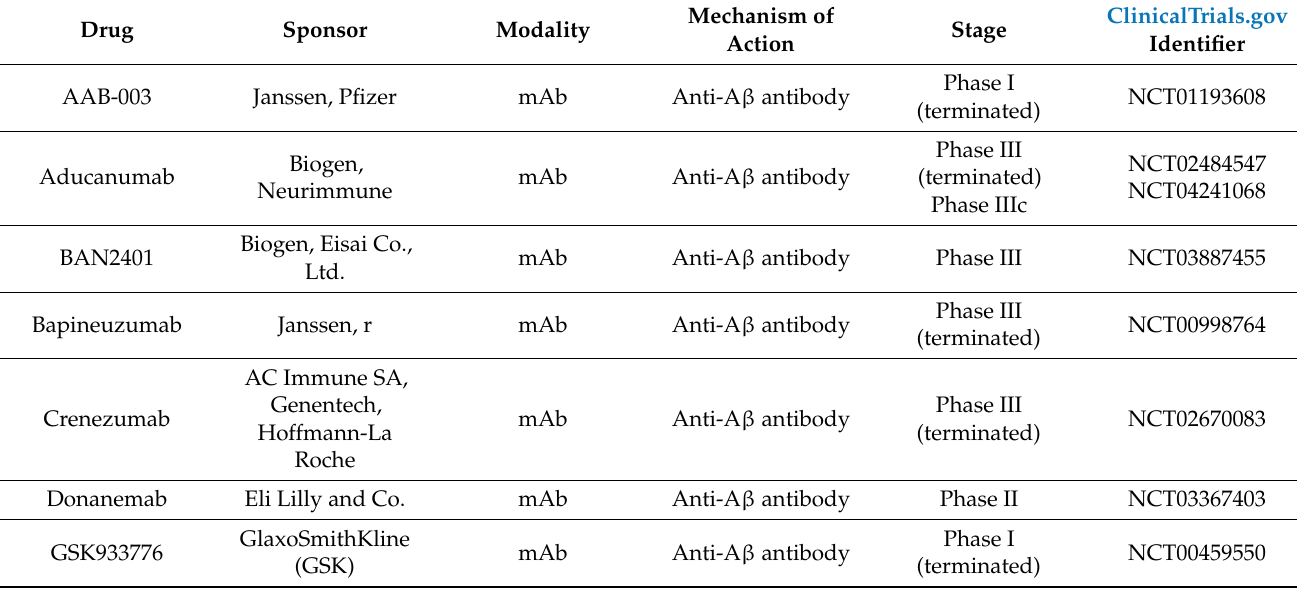
Table 11. Status of select AD drugs in clinical